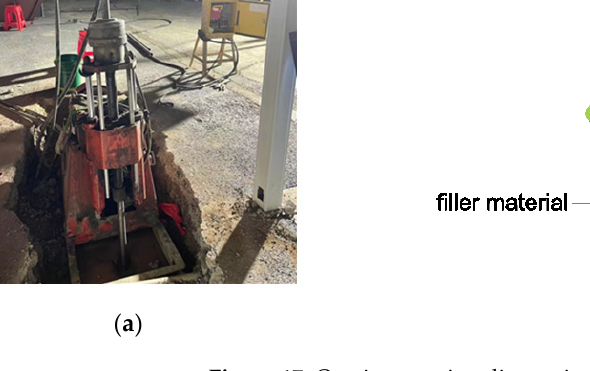
Figure 17. On-site grouting diagnosis and treatment. ( a ) On-site grouting; ( b ) grouting hole layout.